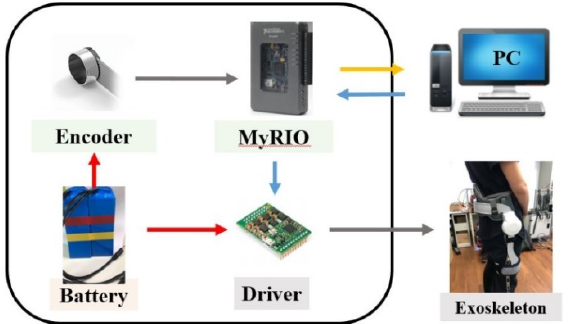
Figure 3. Control circuit and